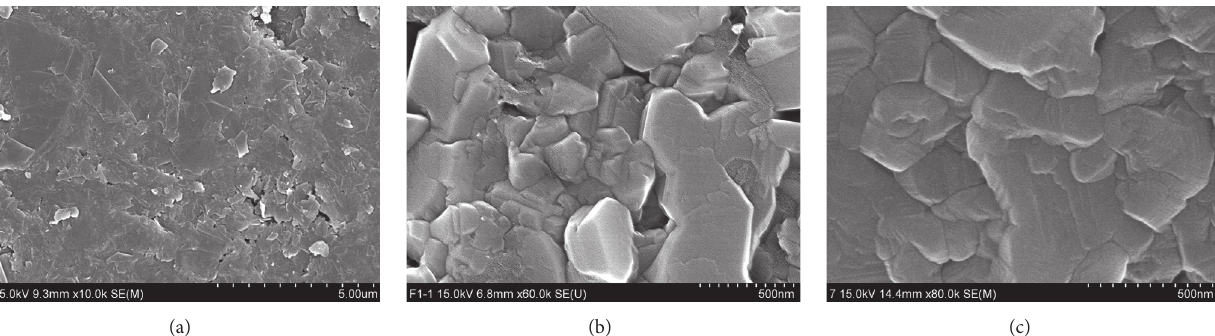
Figure 2: Surface morphologies of (a) bare graphite, the SiC-coated graphite pebbles prepared (b) at reaction zone (1) and (c) at reaction zone (2).